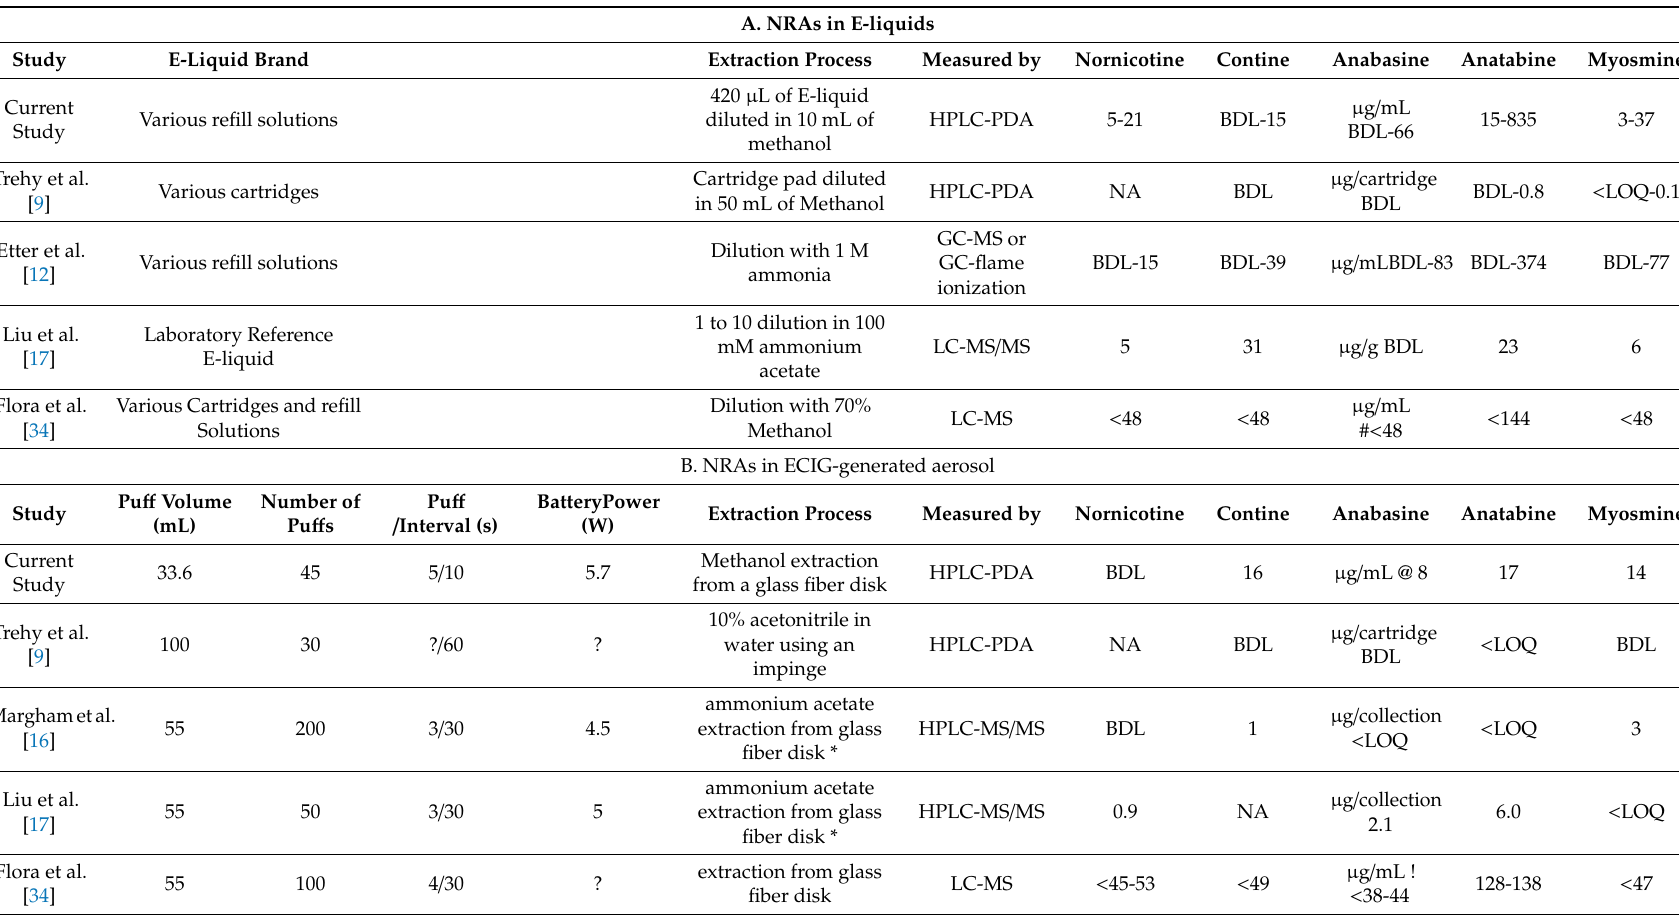
Table 5. Comparison of methodologies and concentrations for nicotine-related alkaloids in ( A ) E-liquids and ( B ) electronic cigarette (ECIG)-generated aerosol of the current study compared with other